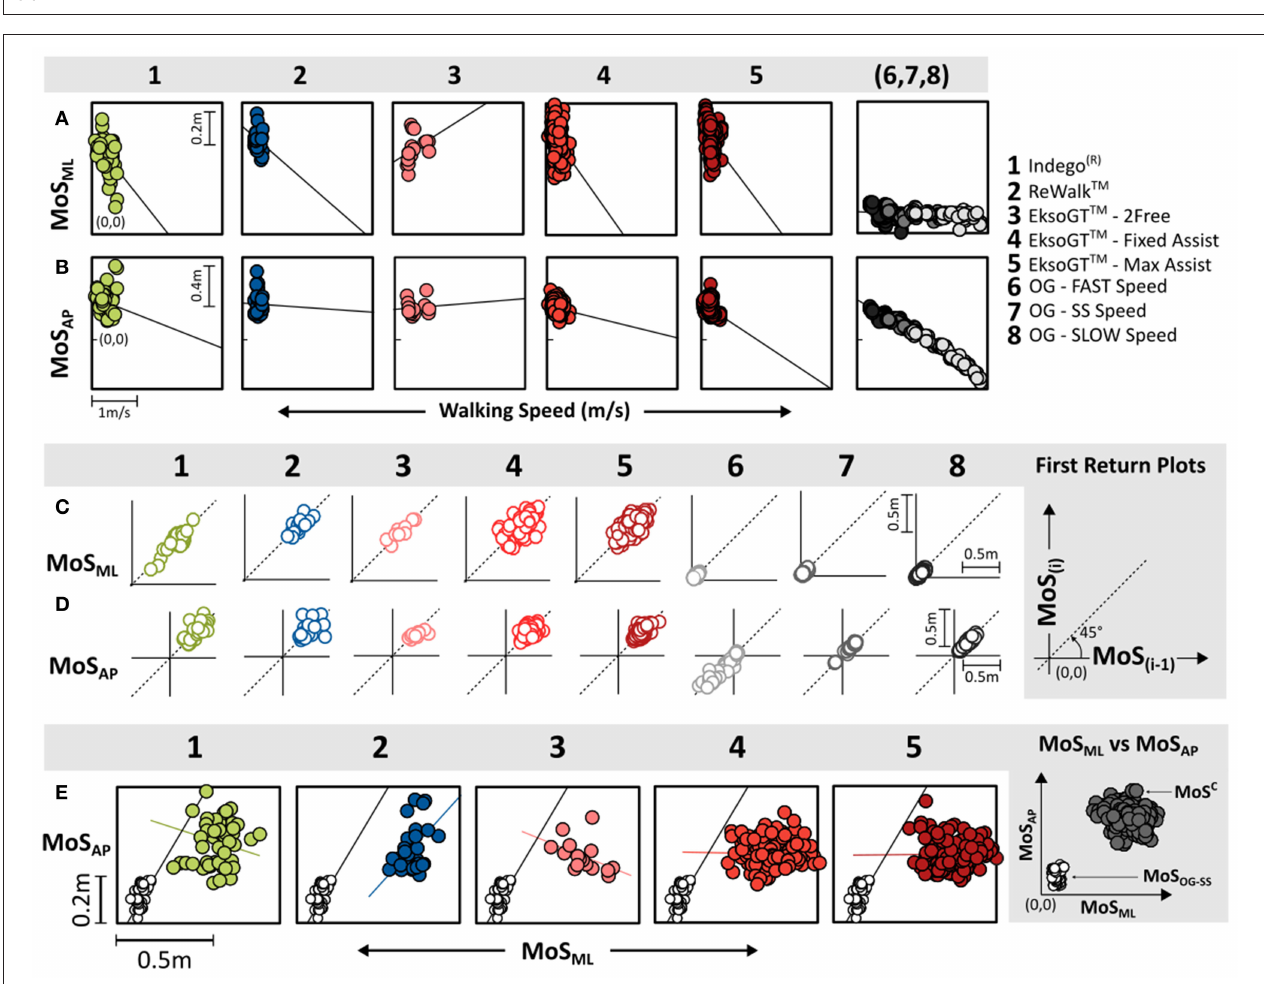
FIGURE 3 | MoS outcomes per condition: correlations for walking speed with MoS outcomes in the (A) ML and (B) AP directions. Stride-to-stride variability shown using first-return plots for MoS in the ML (C) and AP (D) directions. (E) MoS AP vs. MoS ML correlations for OG walking at self-selected (SS) speed and RE walking. MoS outcomes shown for conditions 1–5 are with respect to bilateral crutches, while OG walking conditions (6–8) occurred without crutches.